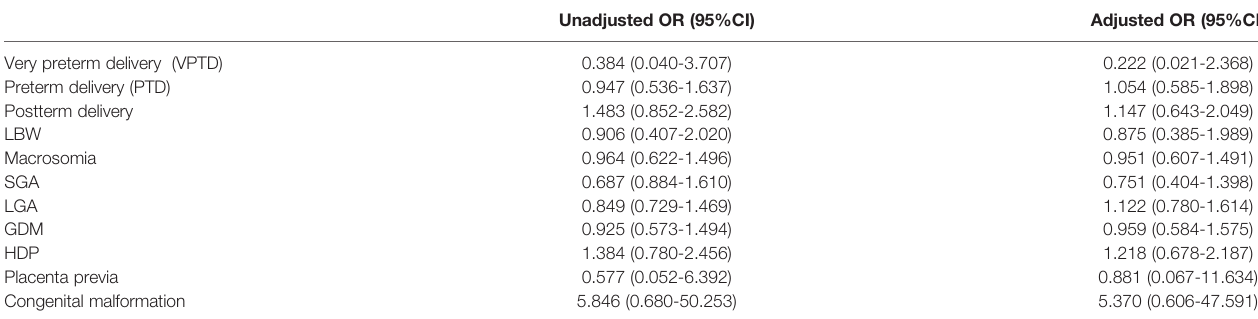
TABLE 7 | Unadjusted and adjusted odds ratios of perinatal and neonatal outcomes of singleton live birth undergoing L-OI versus HRT FET cycles. Unadjusted OR